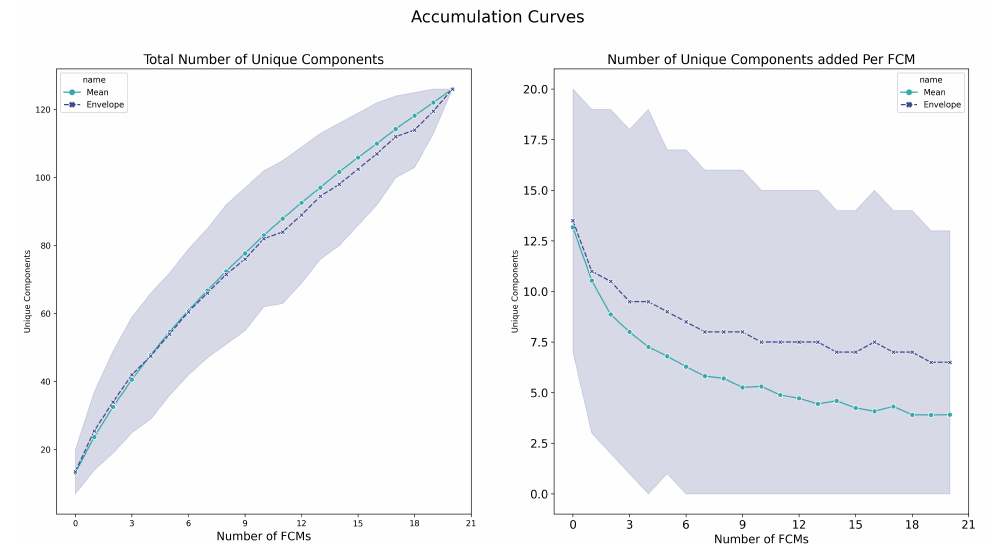
Figure 5. Fuzzy cognitive map (FCM) component accumulation curves representing the total number of unique components for all stakeholder FCMs ( left ) and the number of new unique components added with each additional FCM ( right ). The total number of unique components curve indicates the system has not yet reached a stable state. The number of unique components added per FCM curve indicates that a threshold of about five new variables is added with each additional